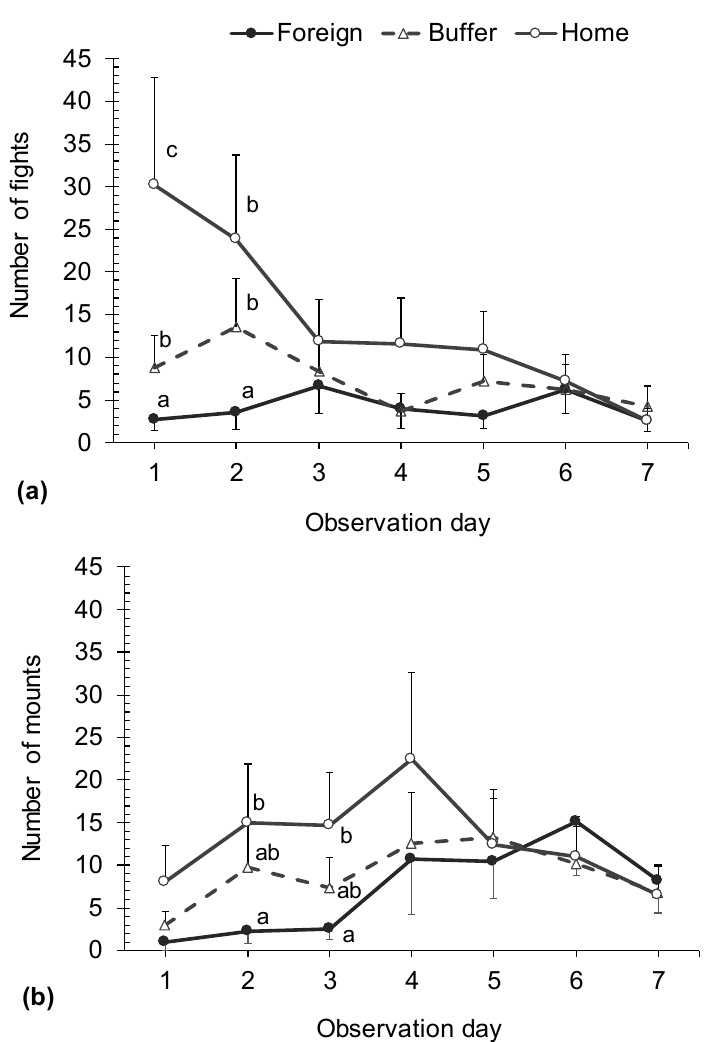
Figure 3. Distribution of within-litter interactions across territories by observation day; ( a ) fighting, ( b ) mounting. Values marked with different superscript letters differed significantly by p < 0.05 (among territories within observation